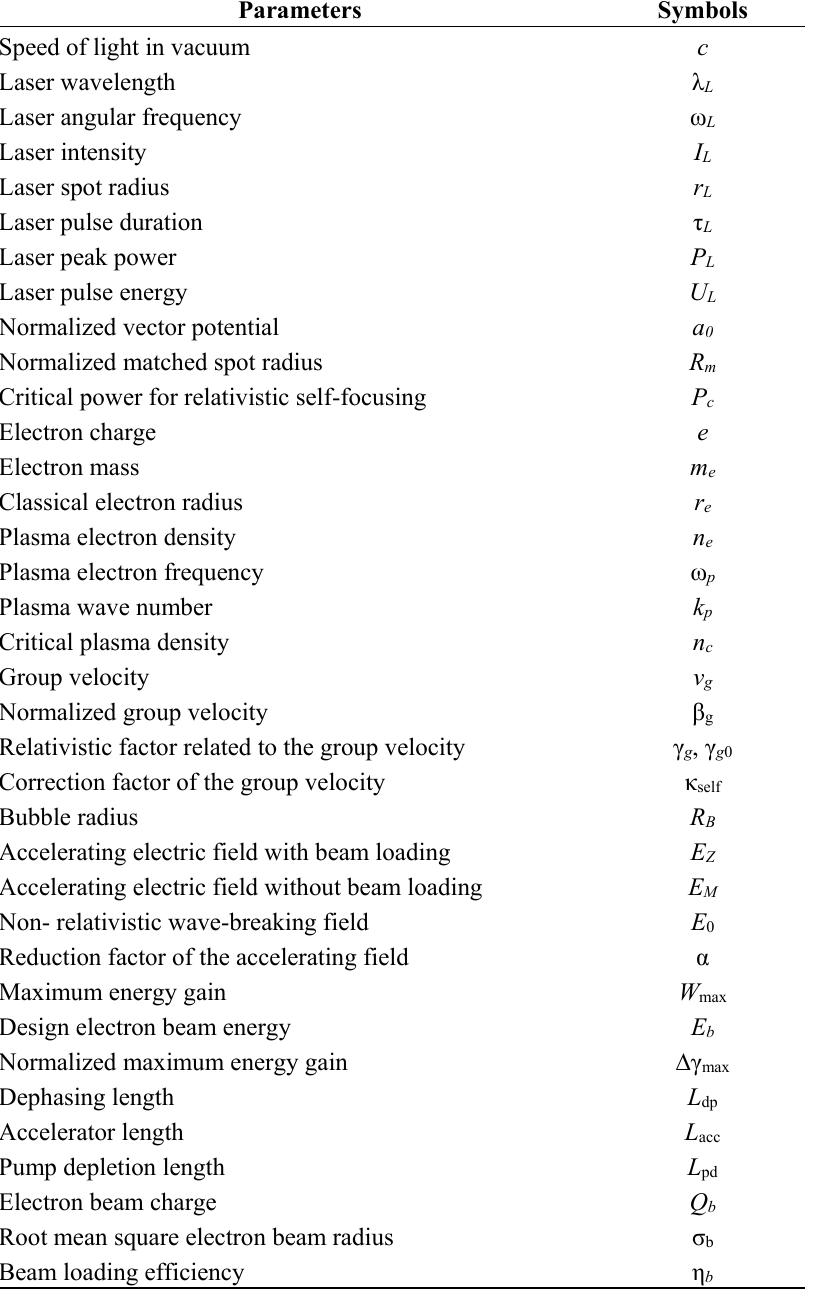
Table 1. A list of symbols for designing laser plasma accelerators. Parameters